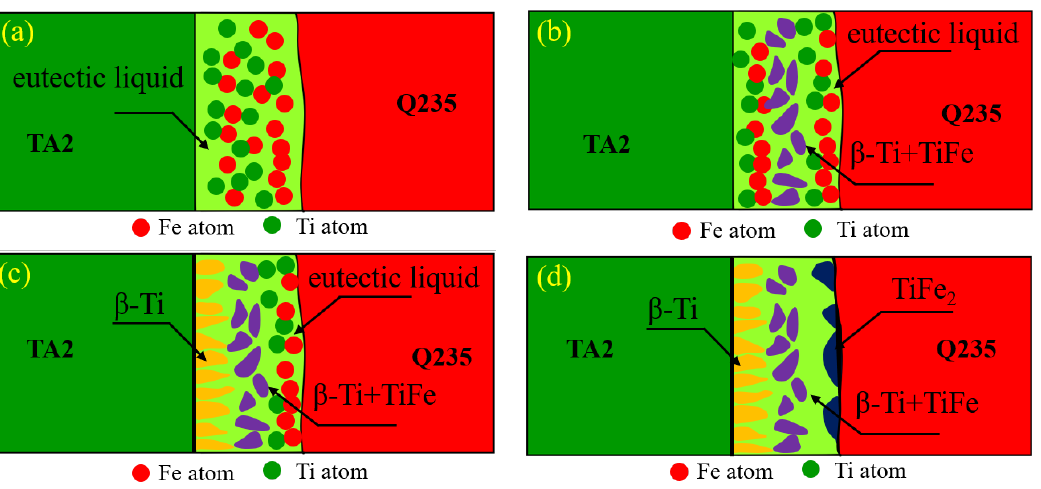
Figure 7. Growth process of the reaction layer during explosive welding: ( a ) dissolution and diffusion of Ti and Fe in the interface; ( b ) nucleation and growth of β-Ti + TiFe eutectic; ( c ) formation of solid-phase reaction layer at TA2 side; ( d ) formation of TiFe 2 in the solid-phase reaction layer at Q235 side.